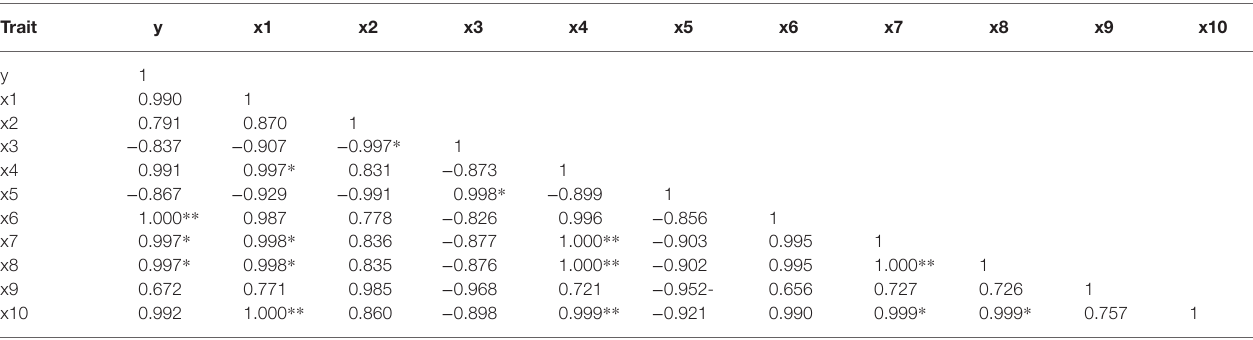
TABLE 3 | Correlation between seed yield per plant and flowering and fruiting factors of Eureka. Trait